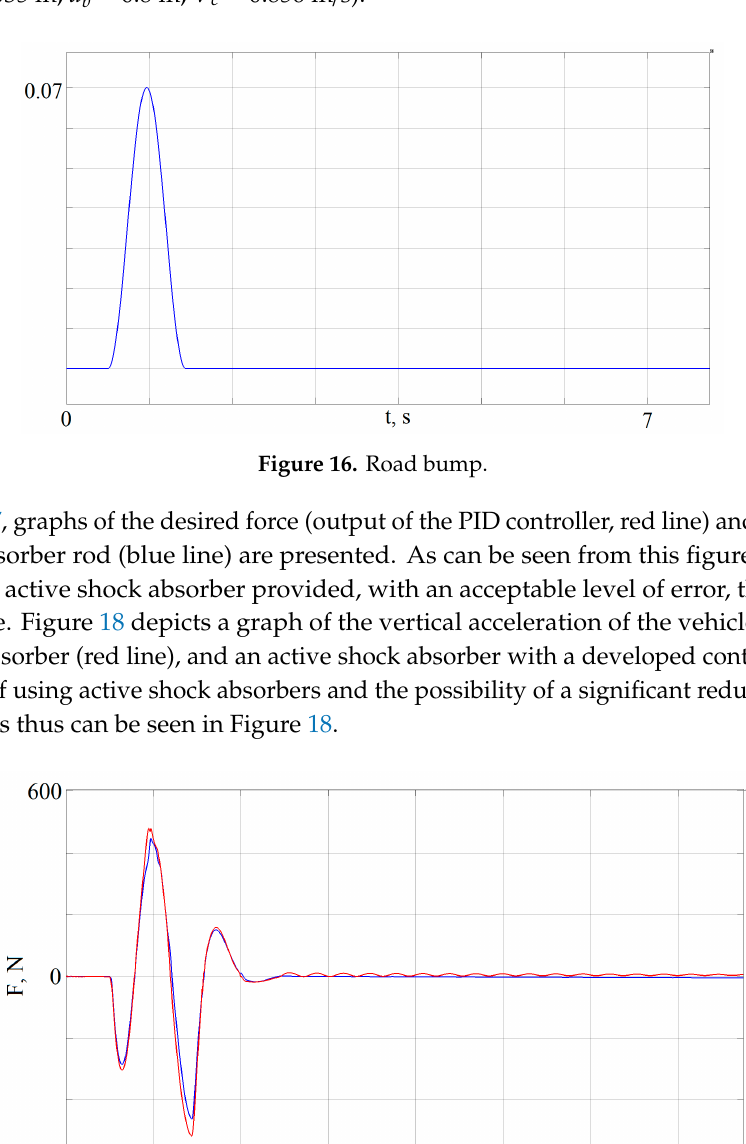
Figure 18. Vehicle body vertical accelerations using passive (red) and active shock absorbers with the developed low level controller (blue). The second type of road input, normally used to analyze the behavior of a vehicle’s suspension, is a periodical excitation. In Figure 19, the results are presented for the sine wave excitation with a frequency of 4 Hz and an amplitude of 0.03 m.